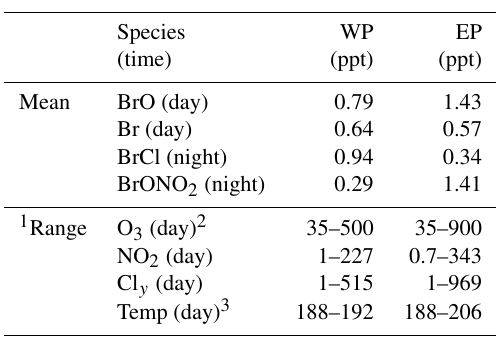
Table 1. Summary of the CAM-Chem model output of Br y species at the tropical tropopause level ( ∼